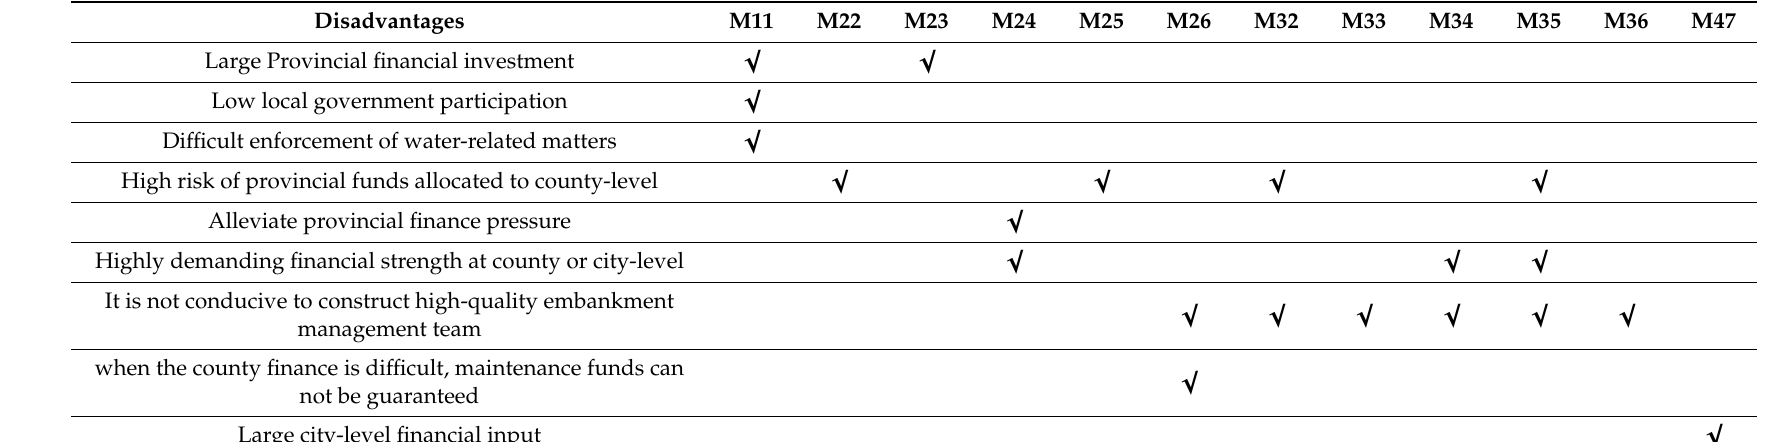
Table A3. Comparisons of river operation management modes’ disadvantages.